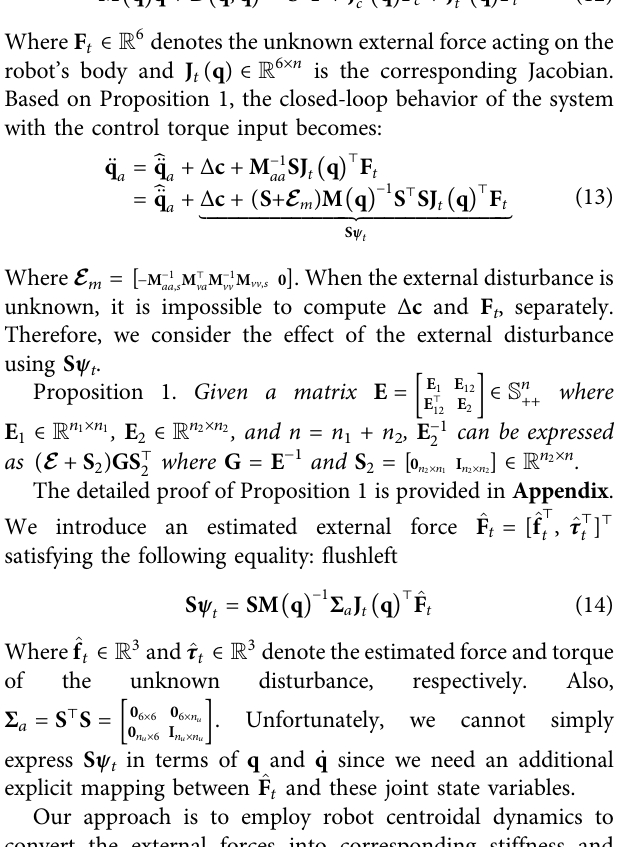
Frontiers in Robotics and AI |